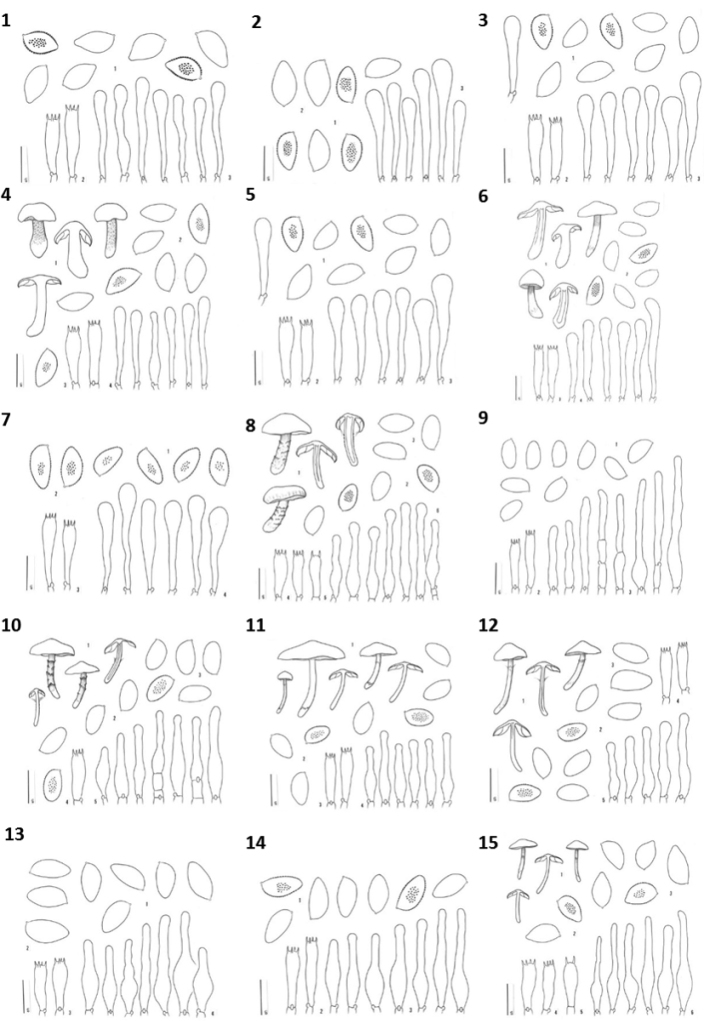
Micro-morphological features (basidiospores, basidia, cheilocystidia) of Hebeloma species found in the Rocky Mountain alpine zone. 1H.vaccinum (holotype, Herb. PC) 2H.aurantioumbrinum ZT12730 3H.subconcolor ZT 13776 4H.hiemale ZT9828 5H.avellaneum DBG-F-019533 6H.velutipes ZT6100 7H.alpinum CLC2875 8H.marginatulum ZT9002 9H.alpinicola ZT13763 10H.dunense ZT9001 11H.mesophaeum ZT8082 12H.excedens ZT7475 13H.oreophilum ZT12733 14H.hygrophilum CLC1462 15H.nigellum ZT6425 16H.spetsbergense micro in Fig. 22. Both two and four-spored basidiospores shown for 2, 5, 7, 8, 10, 12, 13, 15. Scale bar: 10 µm. All drawings by E. Horak.